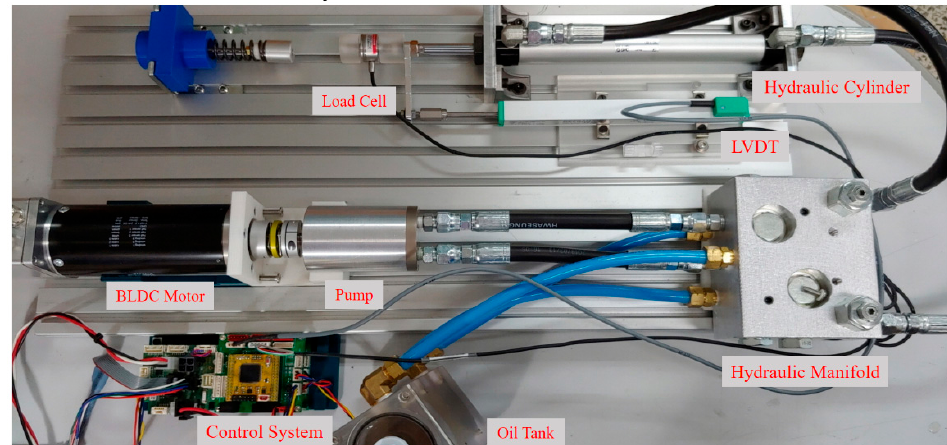
Figure 9. All experiments used a load cell, hydraulic cylinder, motor, pump, manifold, and control system.